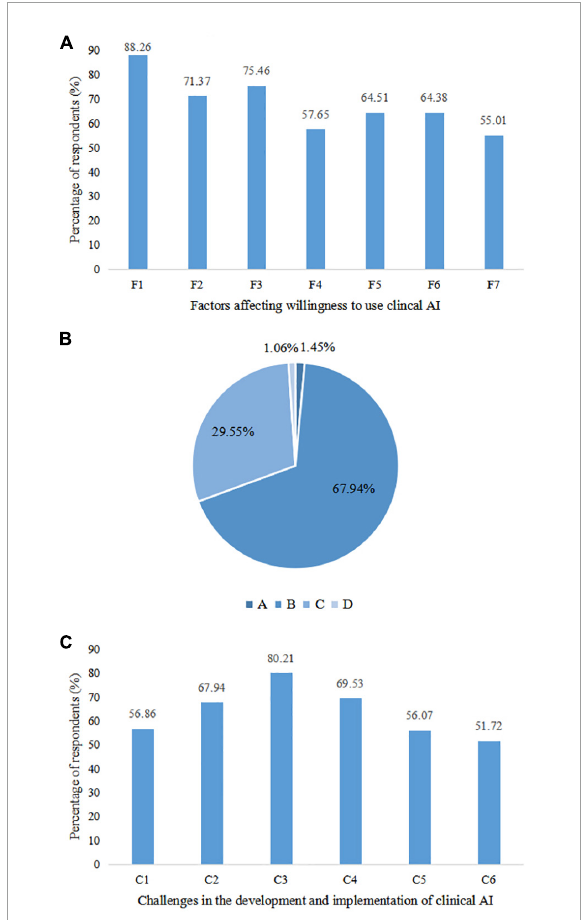
FIGURE4 Factors related to use willingness, perceived relationship between physicians and artificial intelligence (AI), and challenges faced by clinical artificial intelligence (AI). (A) Factors associated with willingness to use clinical AI. F1: Accuracy; F2: Efficiency; F3: Ease of use; F4: Widely adopted; F5: Cost-effectiveness; F6: Interpretability; F7: Privacy protection capability. (B) Perceived relationship between physicians and clinical AI. A: Physicians don’t need to use clinical AI; B: Physicians lead the diagnosis and treatment process while clinical AI only plays an auxiliary role;